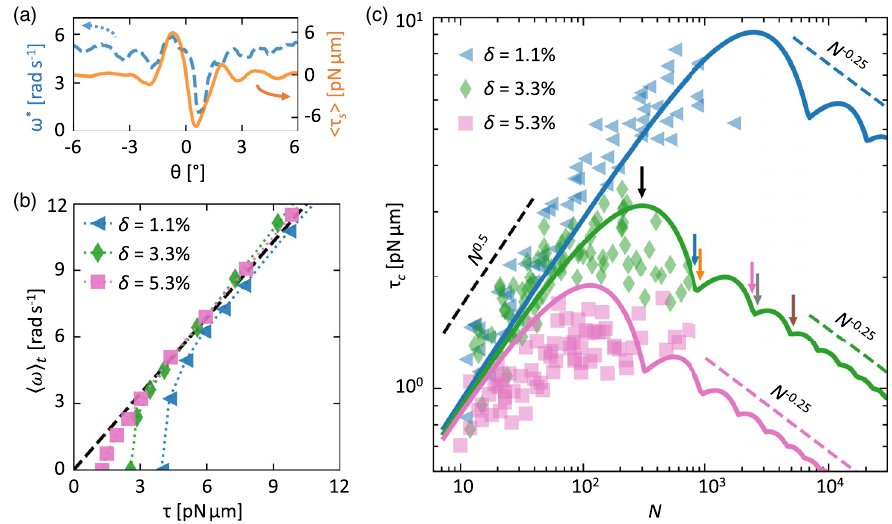
FIG. 2. Critical depinning torque and its finite-size scaling. (a) Measured instantaneous rotational velocity ω (cid:3) and computed average substrate torque h τ as a function of θ for the cluster with N ¼ 1715 rotating on a δ ¼ 1 . 1% surface under applied torque s i τ ¼ 6 . 68 pN μ m. Arrows point at the relevant axis for each curve. At any time instant ω (cid:3) is measured over a time interval of 3.3 s. (b) The measured average rotational velocity h ω (cid:3) i as a function of the applied torque τ for three clusters of similar size ( N ¼ 133 , 114, t 179) in experiments rotating on δ ¼ 1 . 1% , 3.3%, 5.3% surfaces, respectively. hi denotes an average over a time interval where the t cluster rotates more than 180°. The data approach the linear relation (dashed line) h ω (cid:3) i ¼ τ = ð πη a 3 Þ at large τ (viscosity t η ¼ 3 . 2 × 10 − 3 pNs = μ m 2 ). On the other hand, the clusters stop rotating when τ drops below a critical value τ . (c) Data points: c measured critical torque τ as a function of cluster size N on surfaces of different δ . Solid lines: corresponding theoretical curves from c Eq. (3) for circular clusters. Dashed lines indicate scaling relations as discussed in the text. Arrows along the green curve pinpoint cases discussed in Fig.